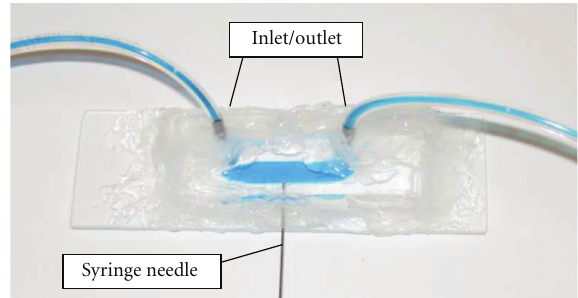
Figure 4: The PDMS test section with blue dye added to the water for